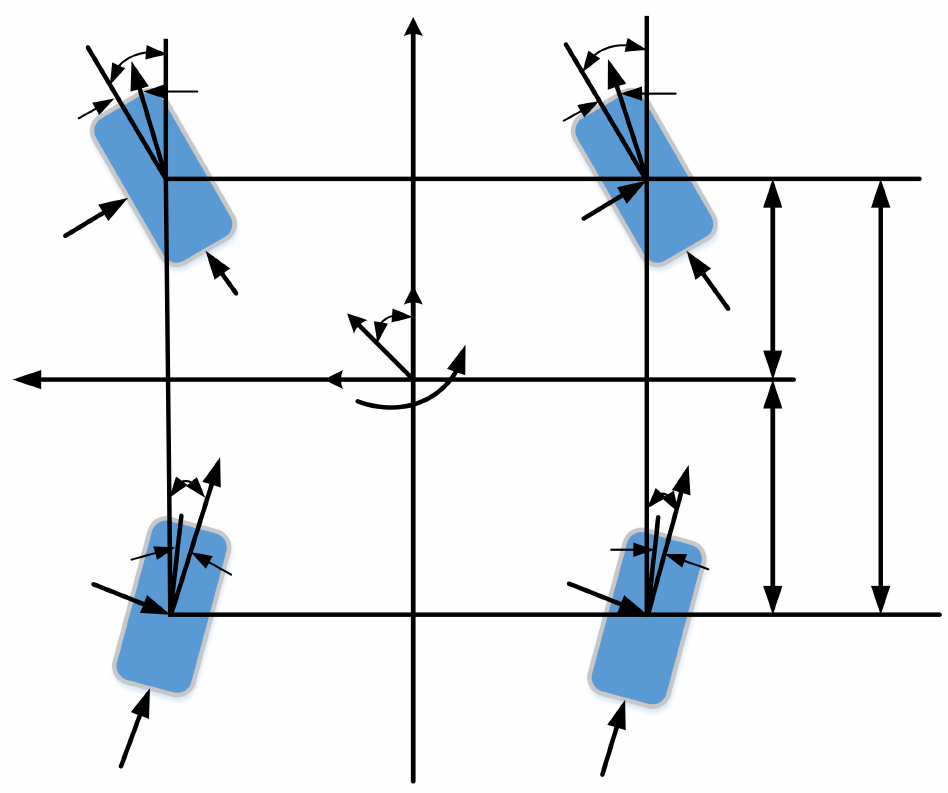
Figure 2. Vehicle